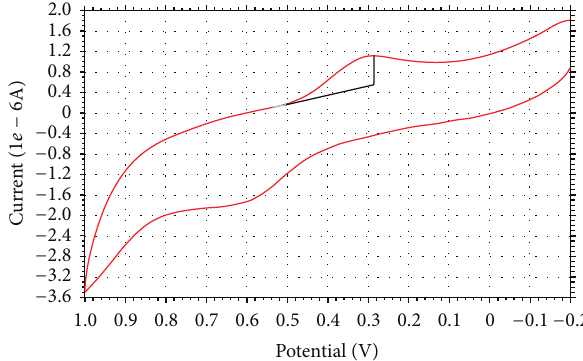
Figure 2: Cyclic voltammogram of Cu(II)